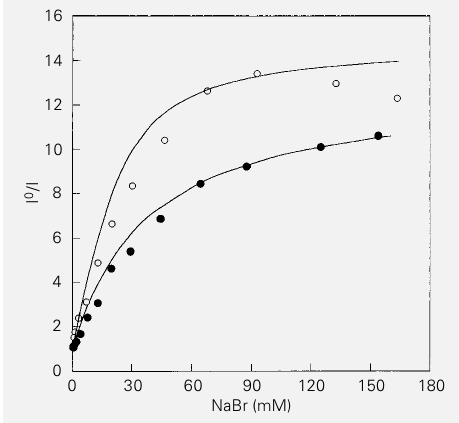
Figure 6 - Stern-Volmer projec- tion for (cid:223)-NBN (4.14 (cid:181)M) incor- porated into 40 mM CTACl mi- celles in the absence ( ! ) and presence ( • ) of 3 M urea as a function of NaBr concentration. Solid lines are from data simula- tion according to the PPIEM for-